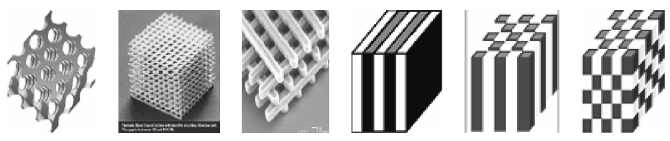
Figure 2: Typical examples of PBG